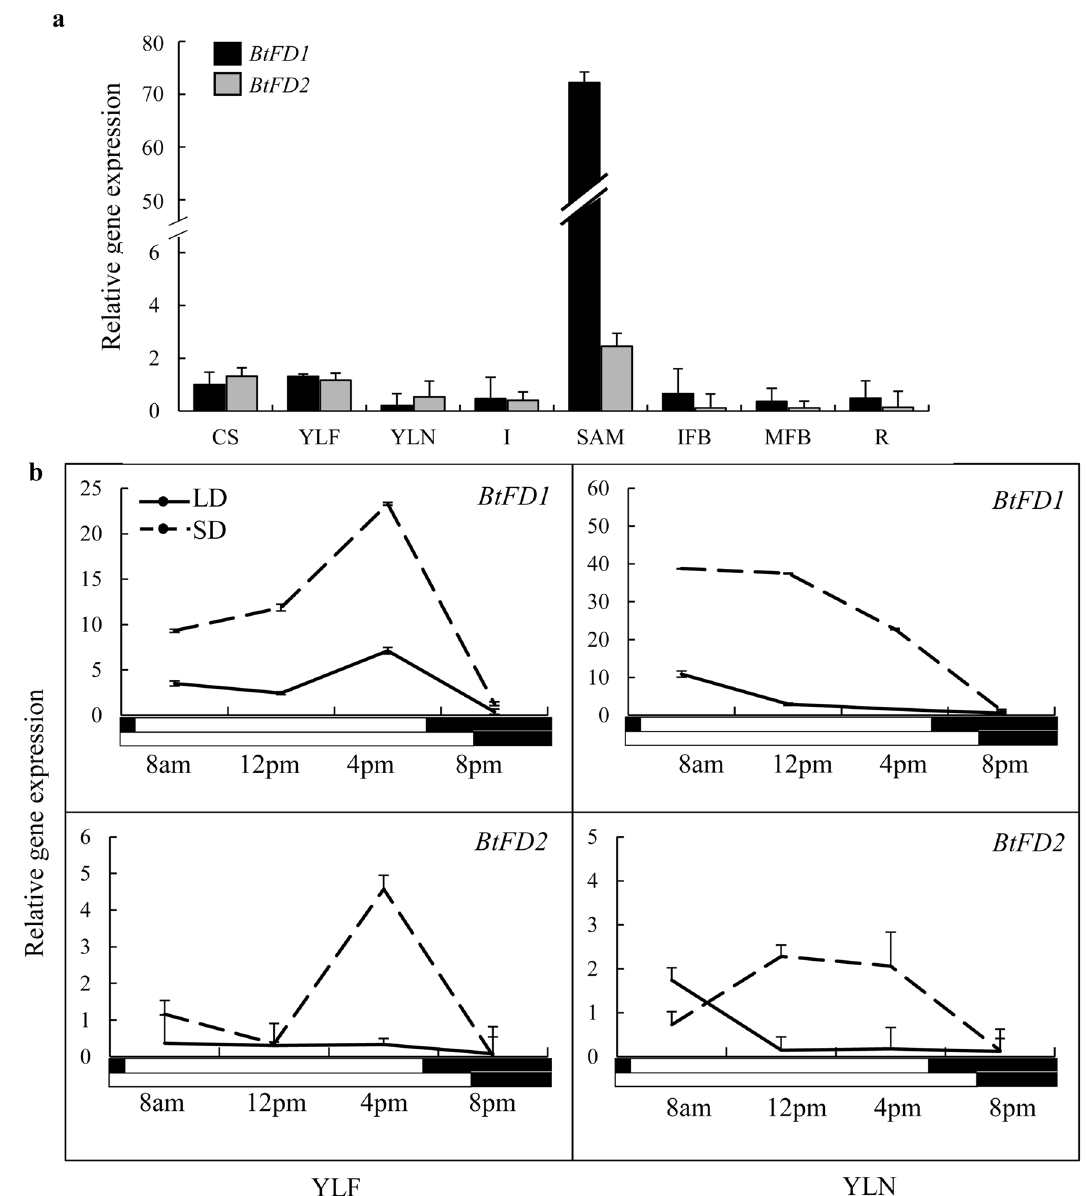
Figure 2. Comparison of tissue specific and diurnal expression pattern of BtFD1 and BtFD2 genes. ( a ) Tissue specific expressions of BtFD1 and BtFD2 in nine different tissue stages of B. tulda . Each bar represents mean of three biological replicates ± SE. ( b ) Diurnal expressions of BtFD1 and BtFD2 in YLF and YLN in SD and LD. Each data point represents mean of three biological replicates ± SE. Transcript expression of eIF4α was used to normalize expression data. The relative fold change was calculated by 2 −ΔΔCT method using the expression data in rhizome as calibrator and is plotted using Y axis. CS culm sheath, YLF young leaf from flowering culm, YLN young leaf from non-flowering culm, I inter node, SA shoot apex, IFB immature floral bud, MFB mature floral bud, R